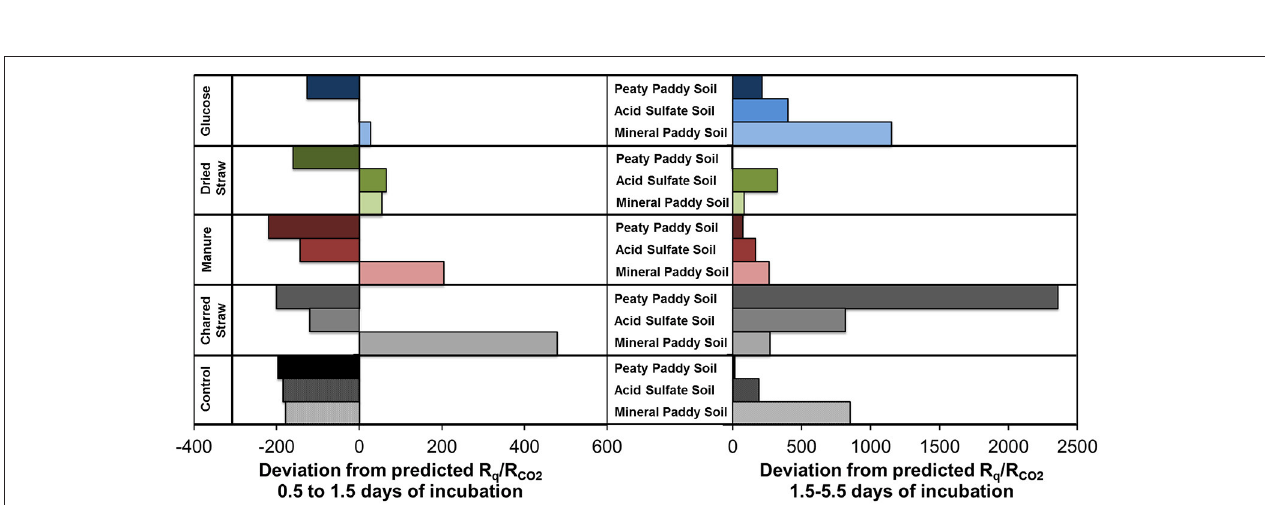
FIGURE 6 | Deviations of measured R q /R CO2 , from those calculated by Equation (1) using NOSC of initial soluble C in soils and amendments, during the first day of incubation (Left) and the subsequent 4 days (Right) . Negative values indicate the measured R q /R CO2 was lower than the predicted value.